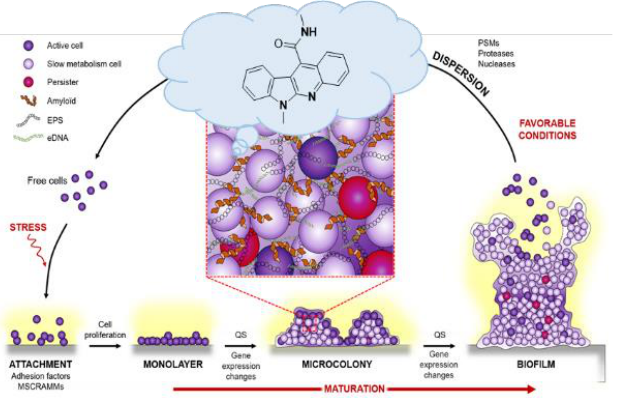
Figure 24. Impact of new indolo[2,3- b ]quinolines on biofilm life cycle. 4.18. Supramolecular Enhancement of Natural 14–3-3 Protein Ligands (P18)